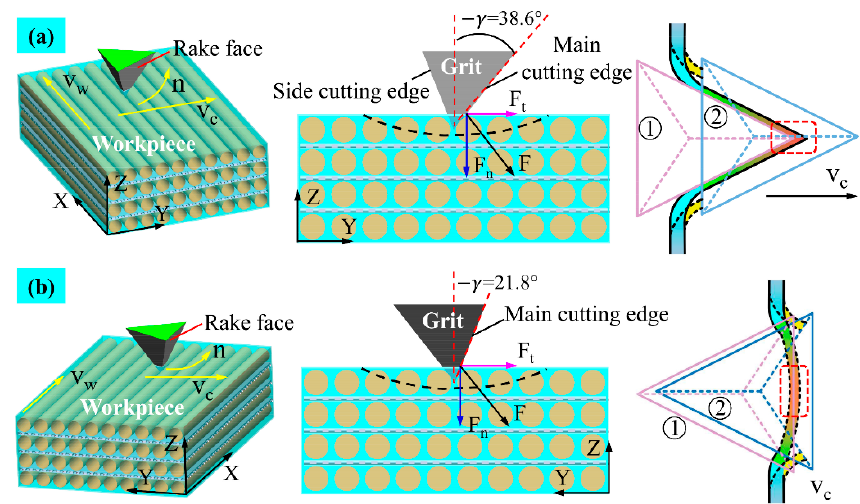
Figure 11. Schematic diagram showing cutting mechanism for triangular pyramid tools when λ = 90 °